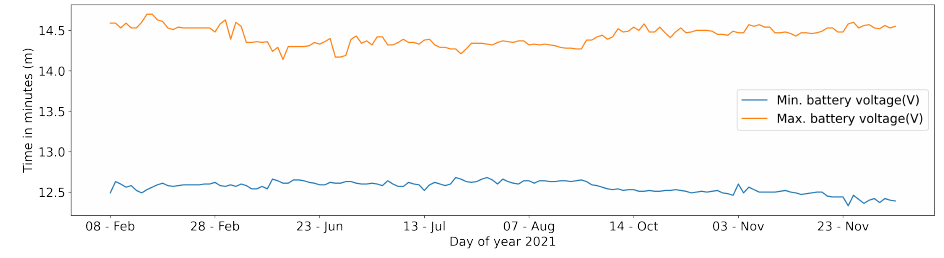
Figure 16. Minimum and maximum battery